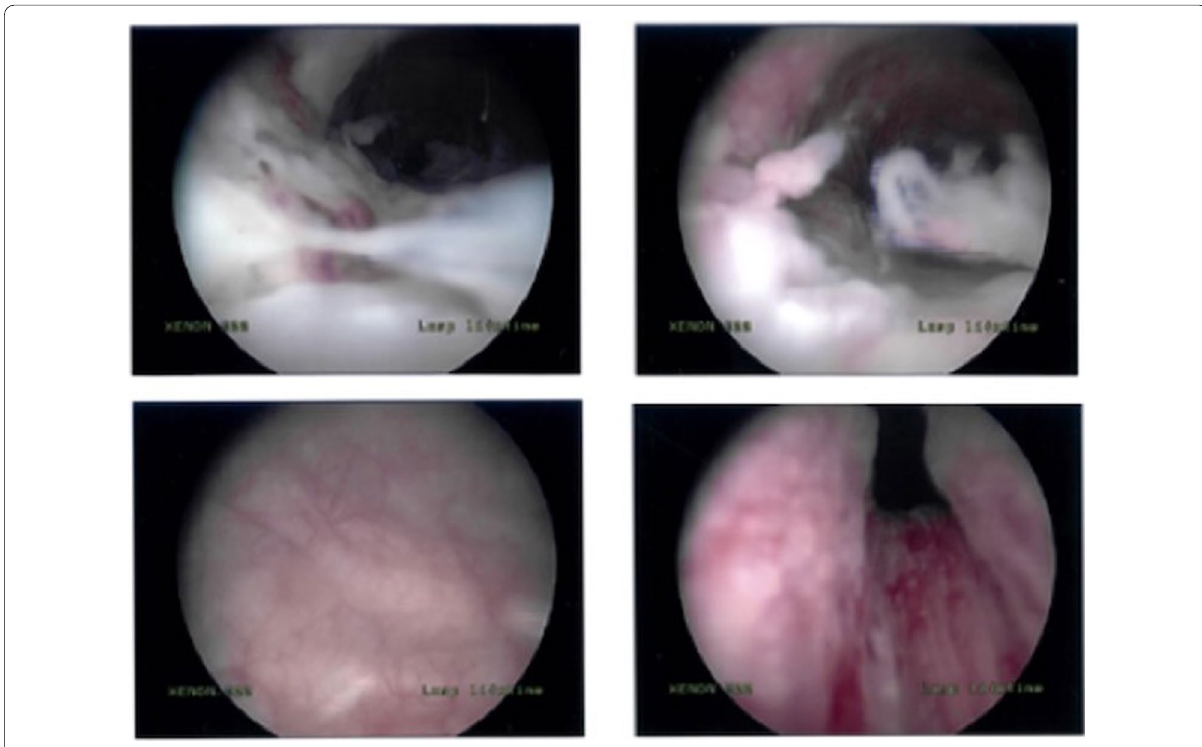
Fig. 5 Urethroscopy after the removal of the foreign bodies showing degree of urothelial